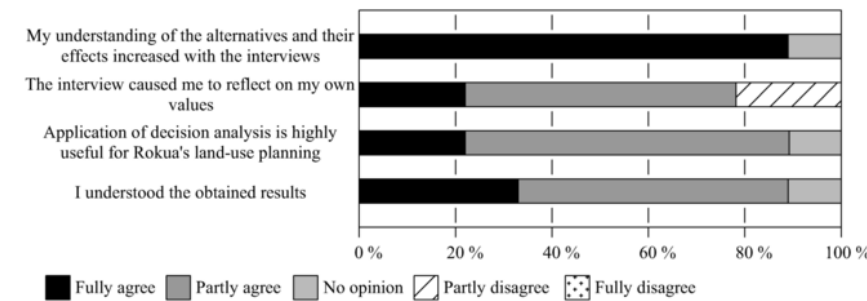
Fig. 8. Results of the feedback questionnaire among the participants of the MCDA